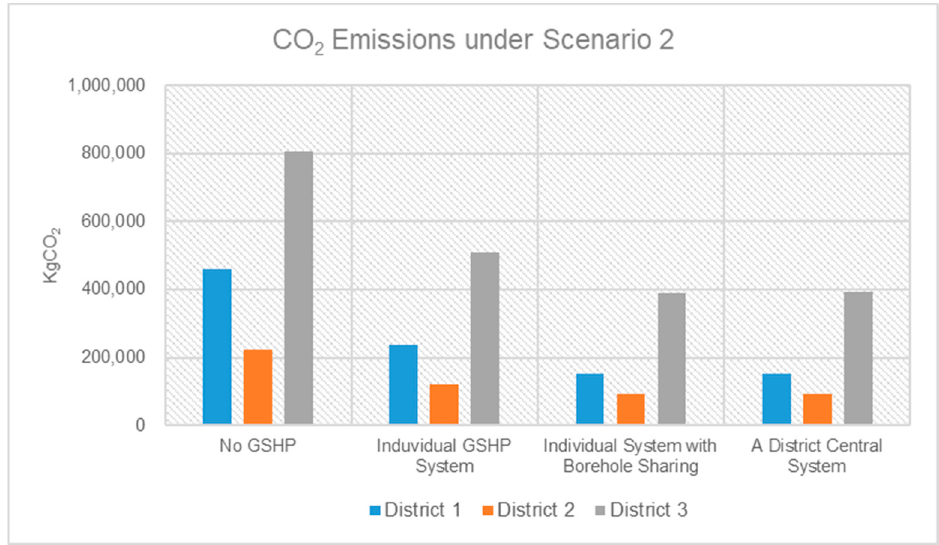
Figure 8. CO 2 emissions of district sharing systems (Scenario 2).